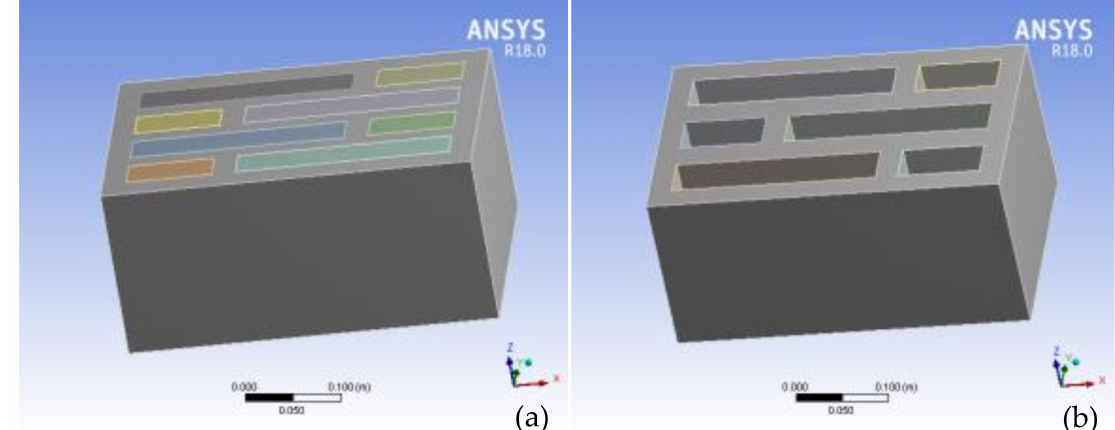
Figure 2. ( a ) Geometric model for the thermal analysis; ( b ) geometric model for the mechanical analysis.